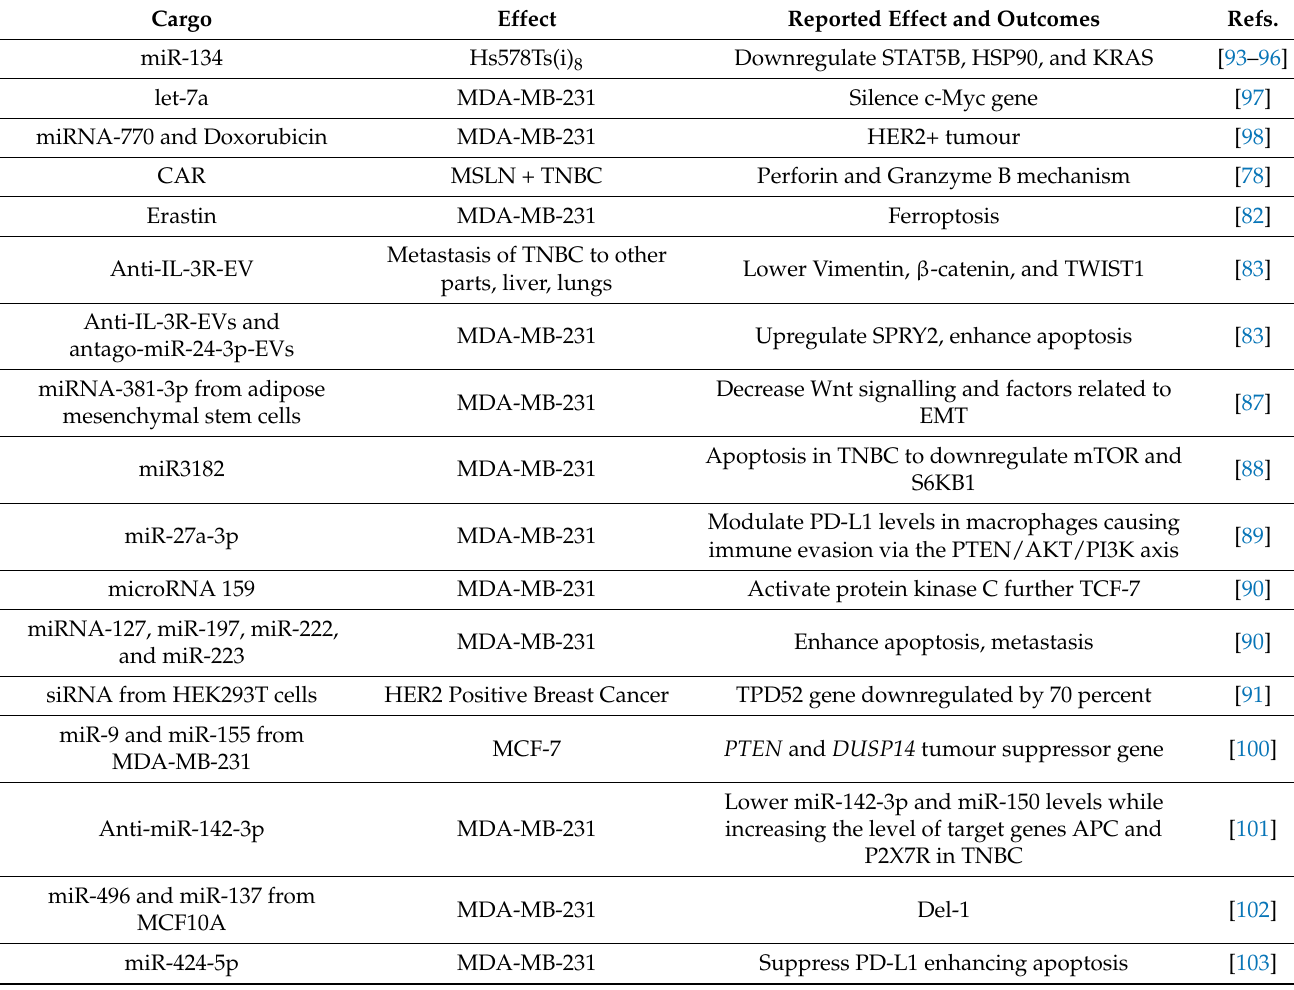
Table 2. Engineered exosomes loaded with different molecular drugs, microRNA, siRNA targeting different signalling, and genes in triple-negative breast